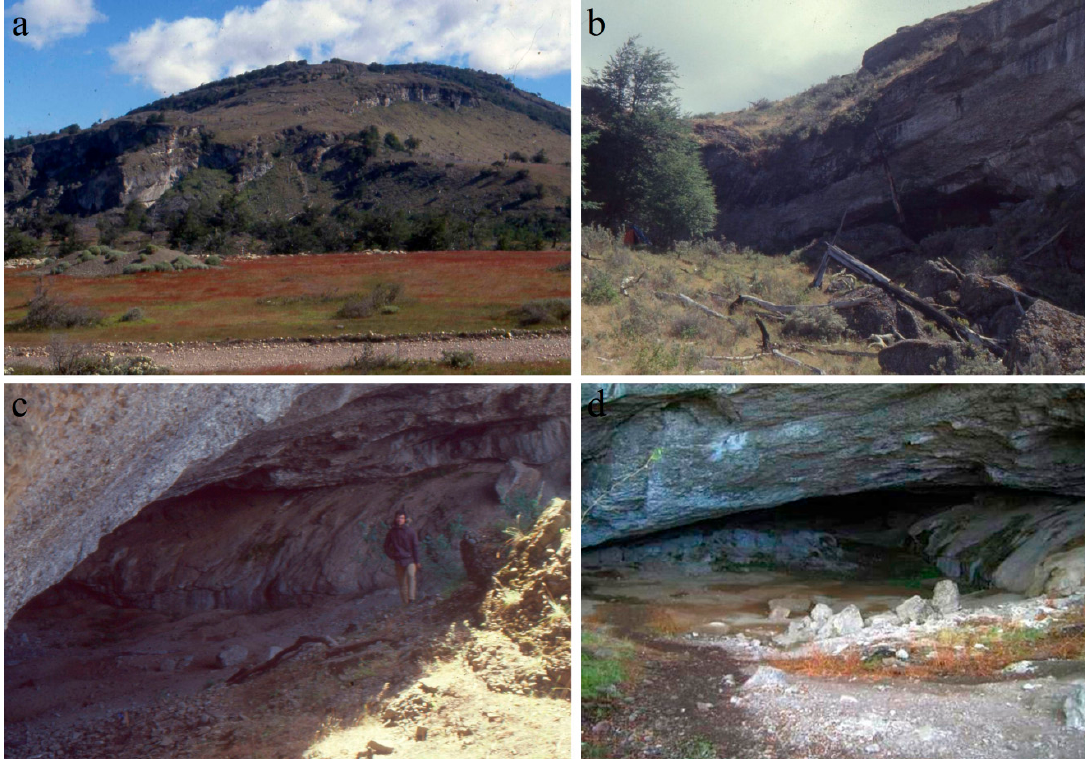
Figure 4. General views of the Cerro Benitez ( a ), and Cueva del Medio ( b – d ). ( b ) entrance, ( c , d ) frontal and inner portions. Except when clearly stated, all the photographs and drawings are by Hugo G. Nami.